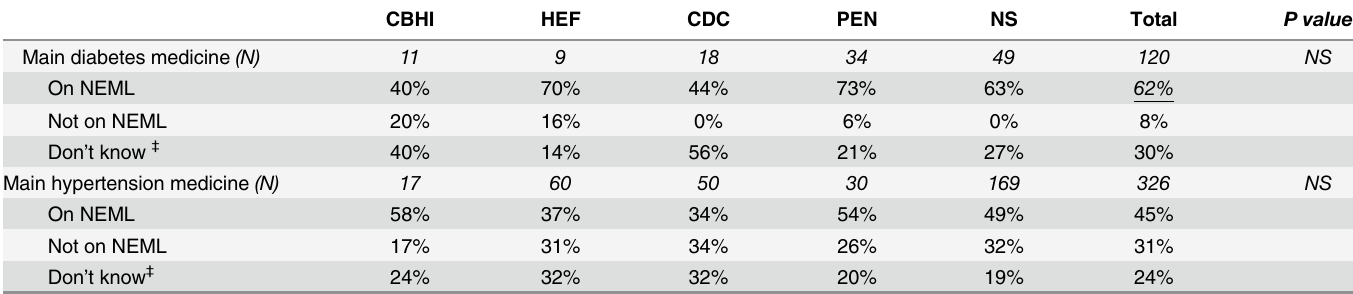
Table 5. Medicines used §.